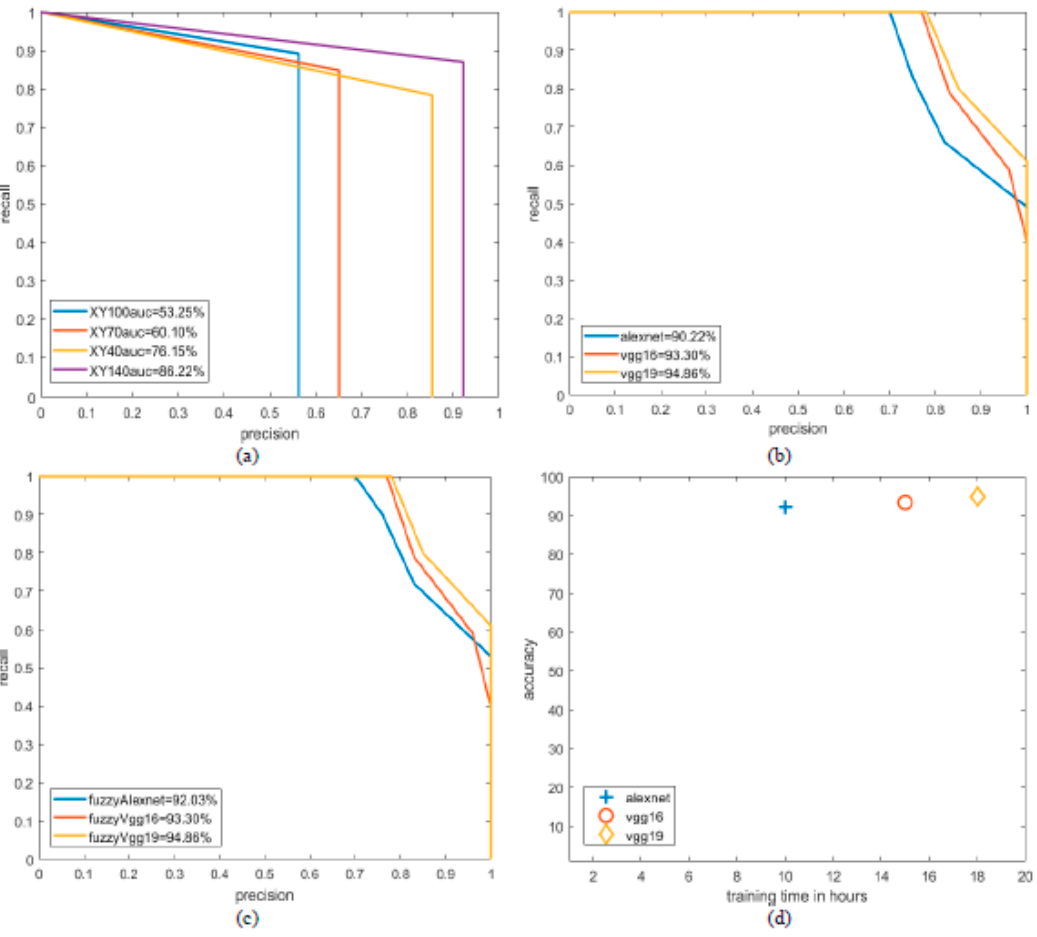
Figure 9. ROC curves and training time vs. accuracy: ( a ) PR Curves of the Proposed Hand Geometry System; ( b ) PR Curves of Convolutional Neural Networks tested on NIR Dataset; ( c ) PR Curves of Convolutional Neural Networks fused with the Fuzzy System; ( d ) Training Time vs Accuracy of the Convolutional Neural Networks on NIR Dataset.